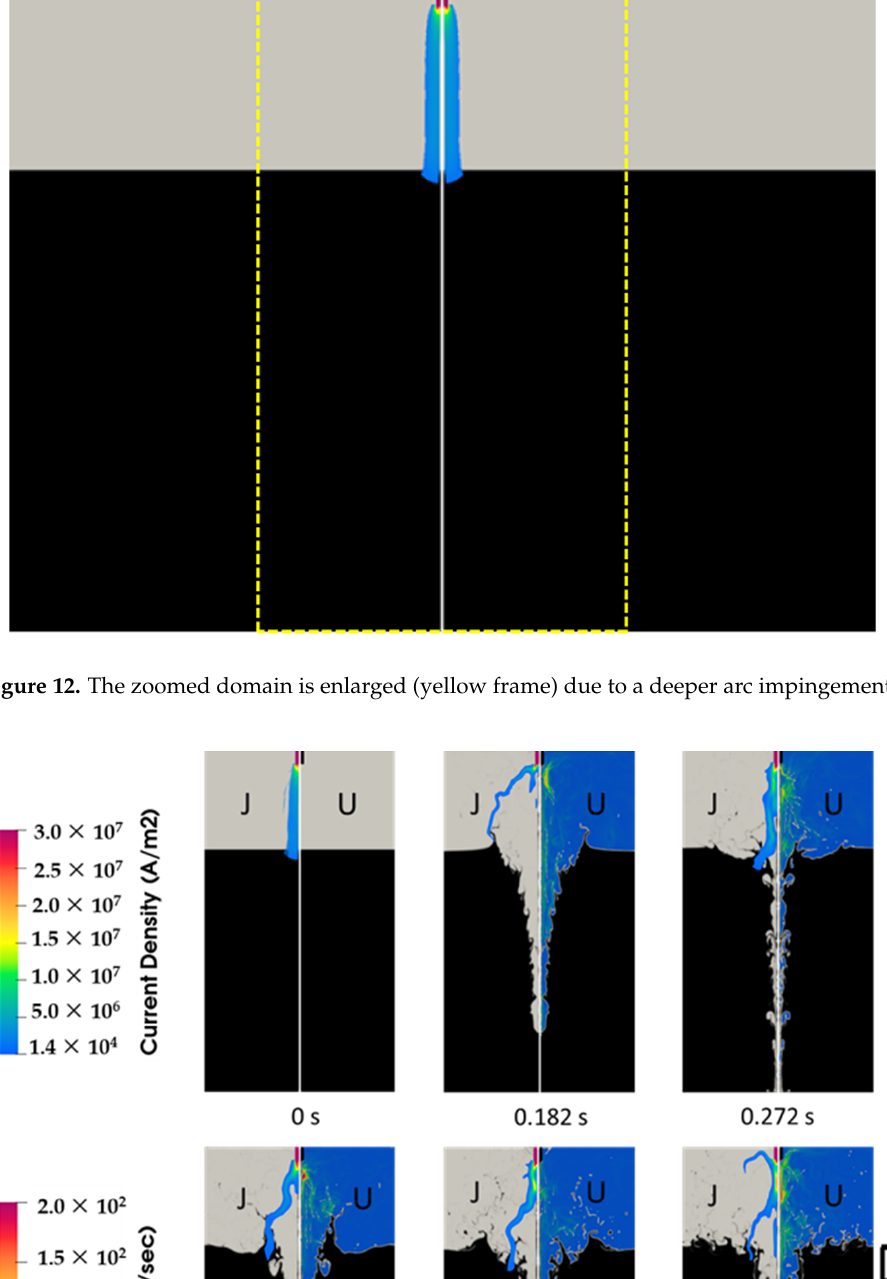
Figure 13. Liquid metal impingement by an arc jet for a total current of 2.0 × 10 1 kA.